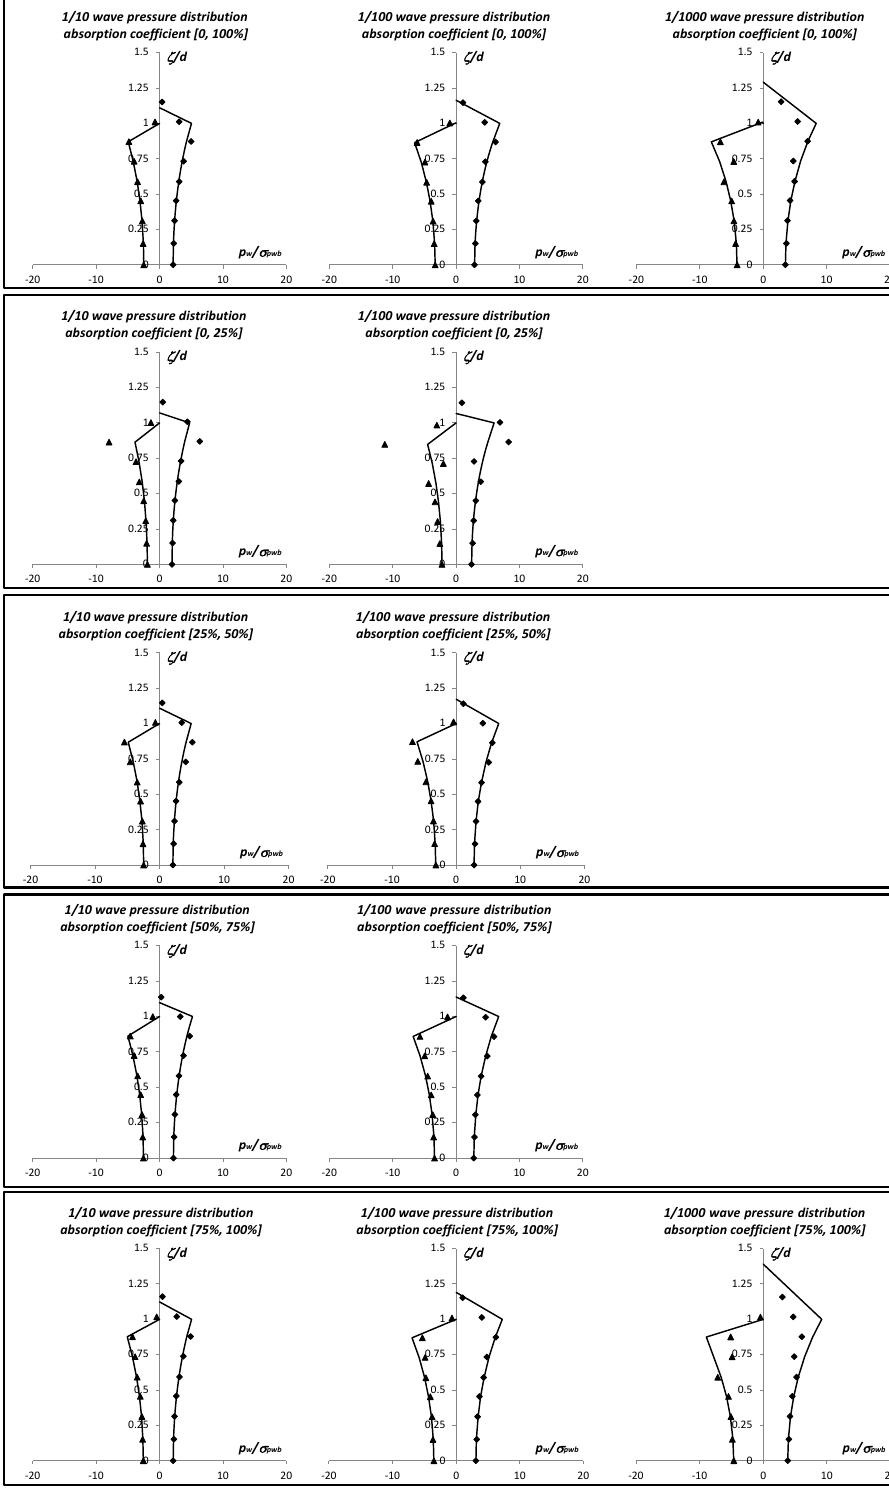
Figure 10. Average of the highest 1/10, 1/100 and 1/1000 wave pressure distribution (crests and troughs) of sea states constituted by wind waves in the fixed interval [0.15, 0.20] of d / L p 0 , for four classes of the absorption coefficient, ranging from 0% to 100%. Points are obtained by means of the experimental measures taken on the front wall of the U-OWC. The continuous lines are obtained by means of the linear wave